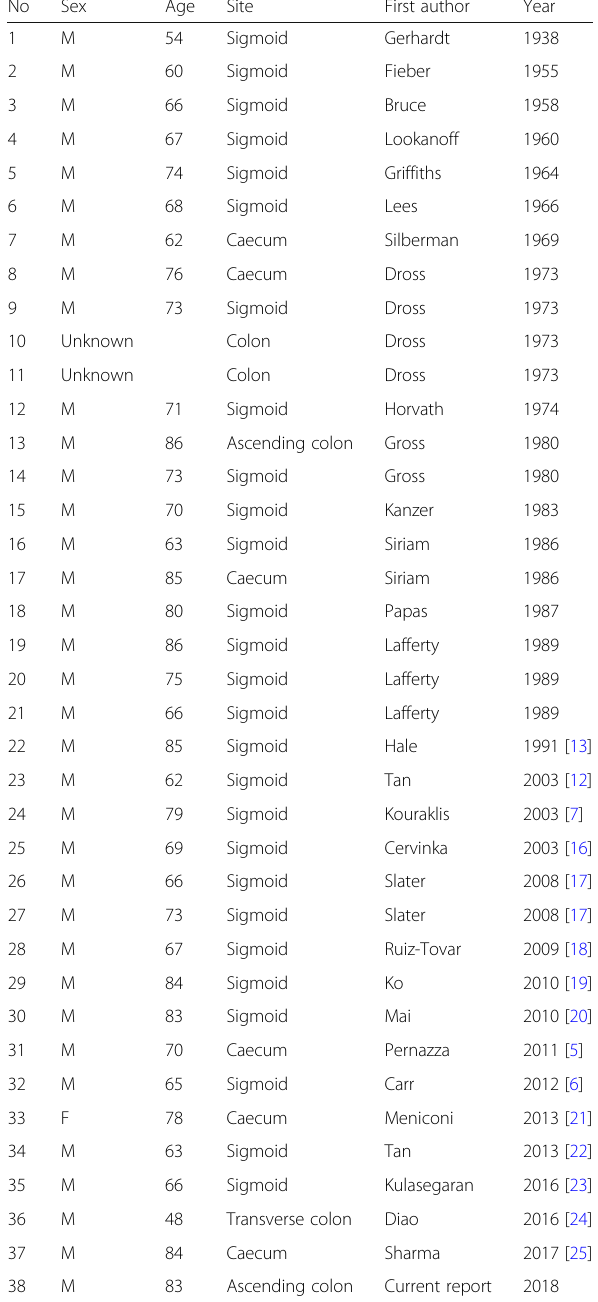
hernias (adapted from Matsumoto et al. [3] and Slater et al.